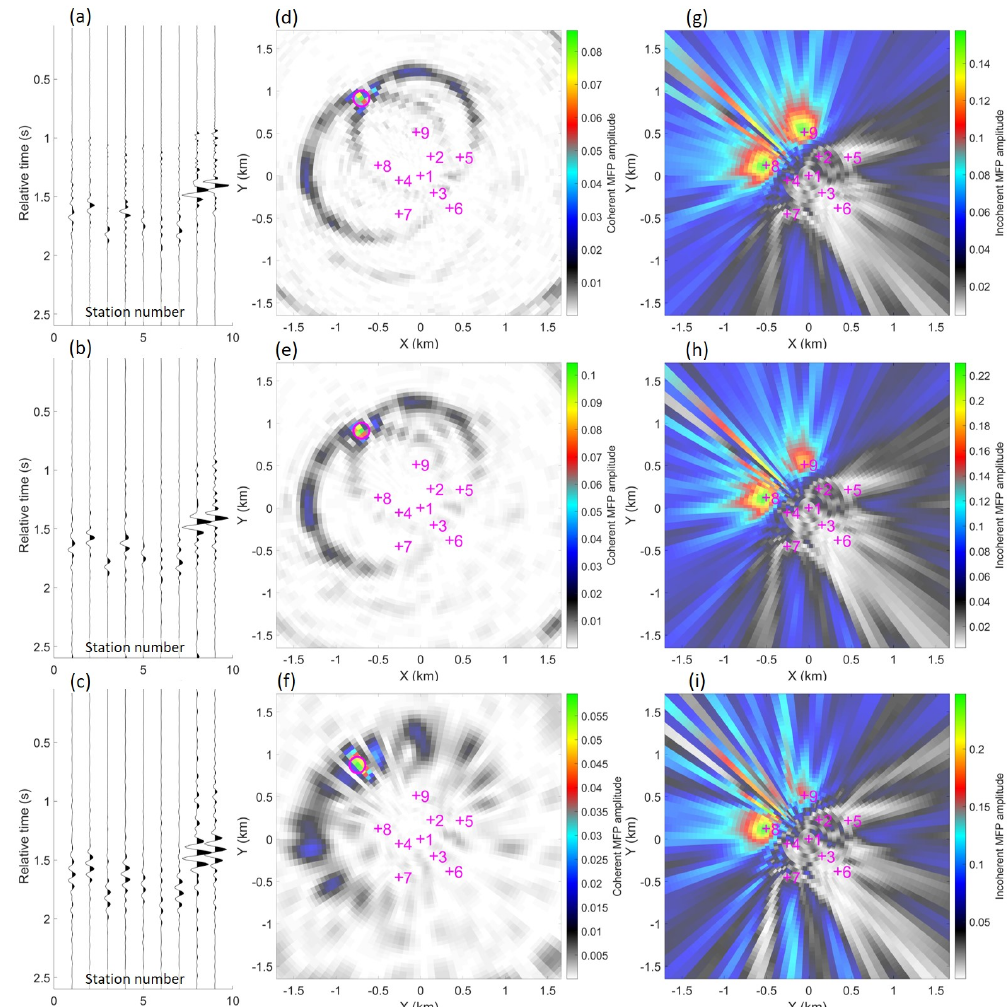
Figure D1. Example of MFP source location for an event with a dominant frequency of 10.2Hz and half-power bandwidth of 6.7Hz (same event as shown in Fig. 5b) filtered to passbands of (a) 5–35Hz, (b) 5–15Hz, and (c) 7.5–12.5Hz prior to MFP. Panels (d) , (e) , and (f) show corresponding coherent-MFP ambiguity surfaces, while panels (g) , (h) , and (i) show incoherent-MFP ambiguity surfaces. The Cryosphere, 16, 2025–2050, 2022